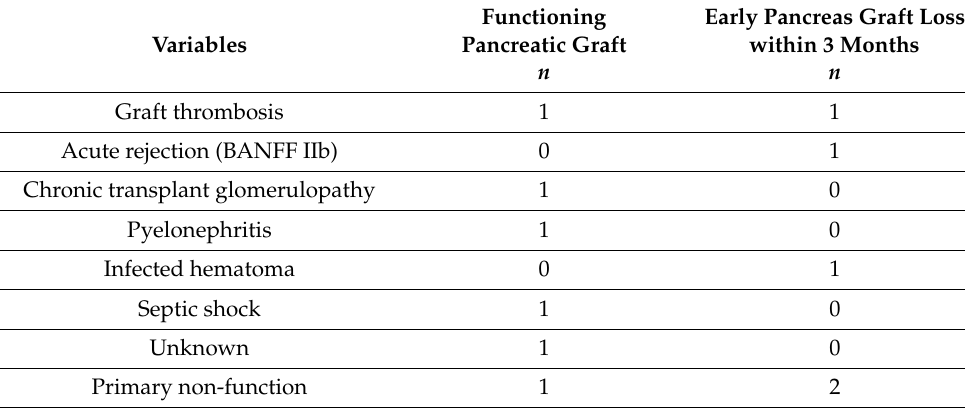
Table 3. Causes of kidney graft failure.